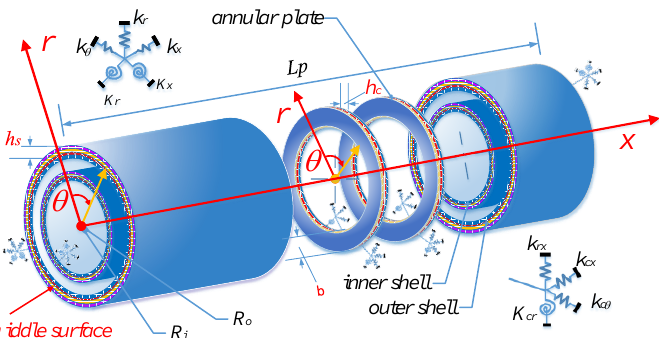
Figure 1. Model of the laminated composite double cylindrical shell system (LCDCSS) with general boundary conditions.